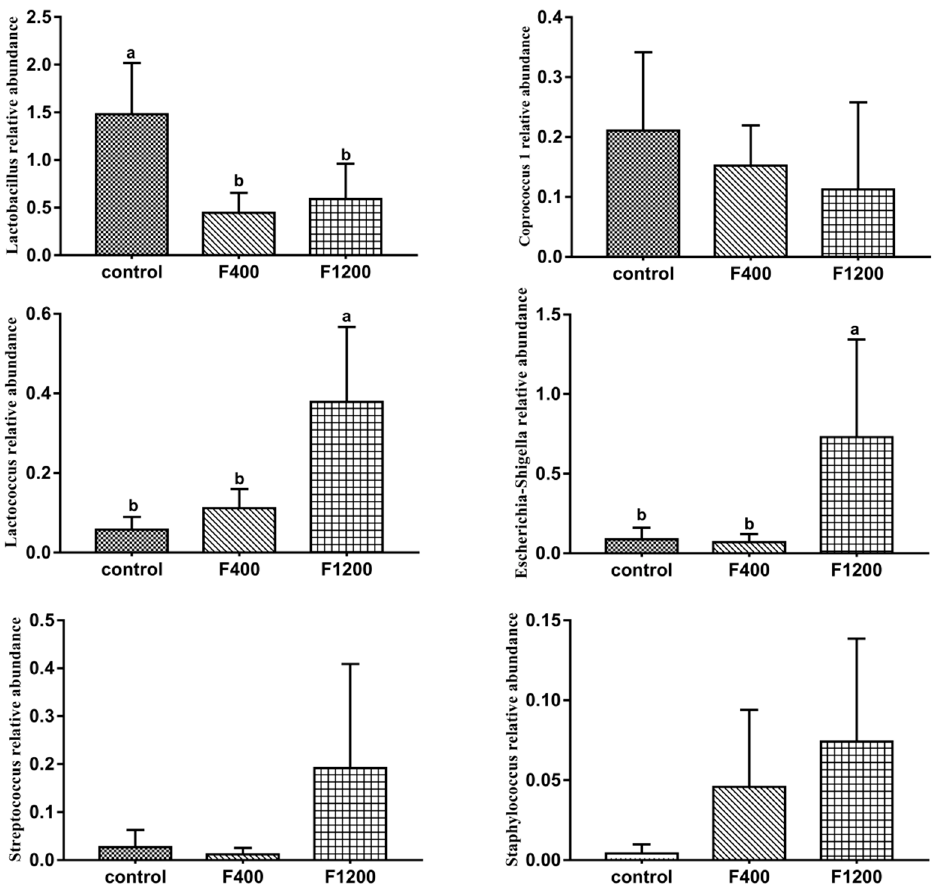
Figure 8. Effects of dietary fluoride level on the relative abundance of intestinal opportunistic pathogen and beneficial bacteria in cecum of laying hens. Values are means ± SD ( n = 5). a–b Means with different superscript letters are significantly different ( p < 0.05). CON, the control group, basal diet; F400 and F1200, diets supplemented with 400, and 1200 mg F/kg feed from sodium fluoride, respectively.